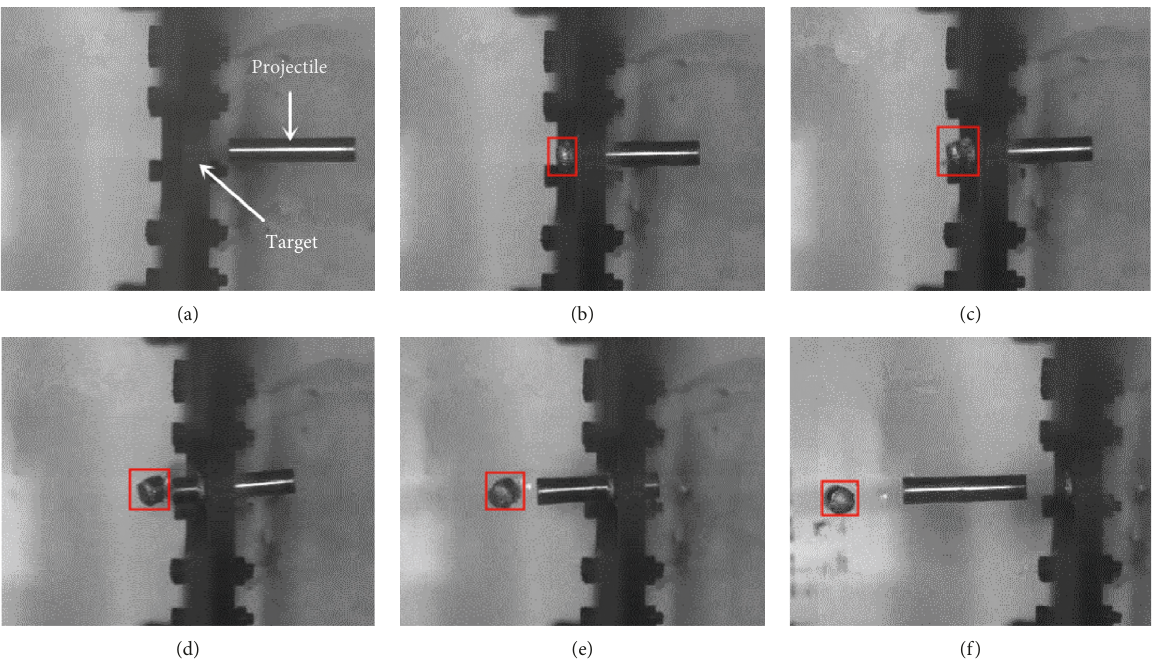
Figure 11: Penetration process of target plate under projectile impact at V